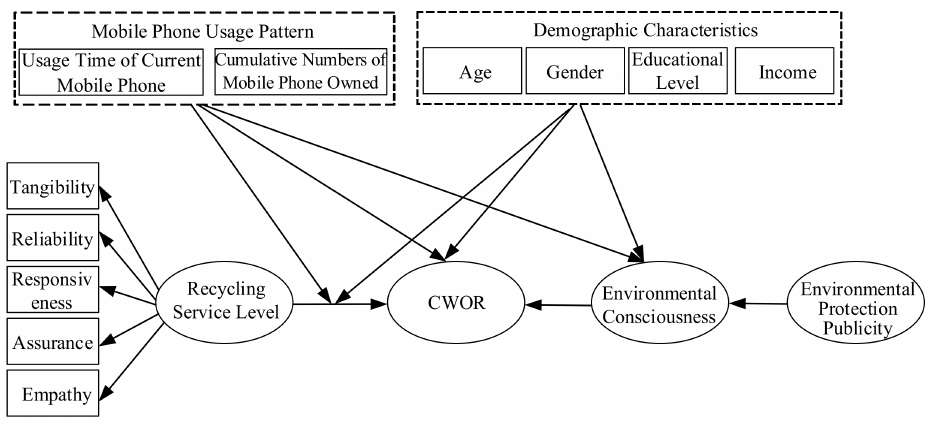
Figure 7. The research model of the influencing factors of